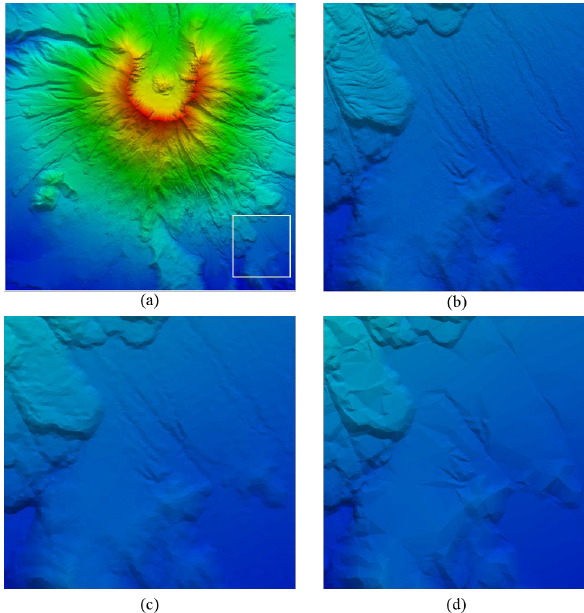
Figure 14. Detail loss of the HFPR generalisation grid. The in- spected area in the experimental site is bounded by the white rectan- gle (a) ; the magnified inspection area on the original dense TIN (b) ; the area on the cCVT-generalised TIN (c) ; and the area on the HFPR-generalised TIN (d) . From the close-up view, it can be seen that the HFPR method generates a rougher grid than the CVTs. Thus, structural distortion or misconfiguration might be introduced.